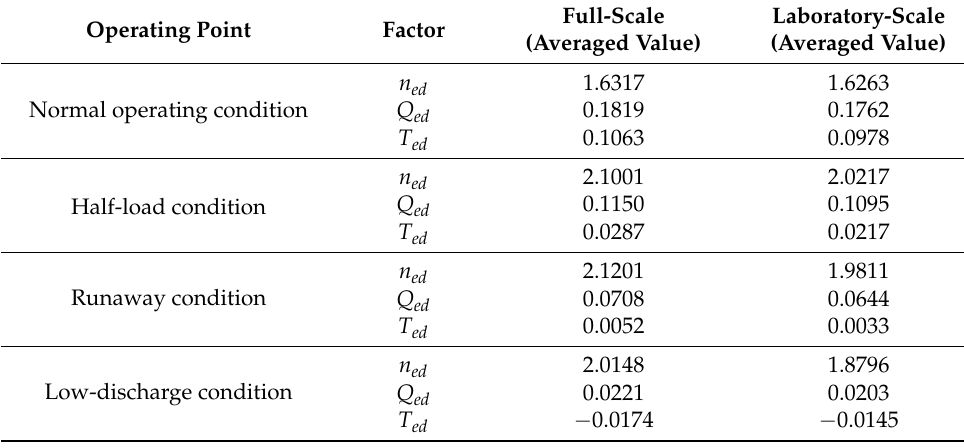
Table 7. Unsteady-state results of full- and laboratory-scale models at 21.5 ◦